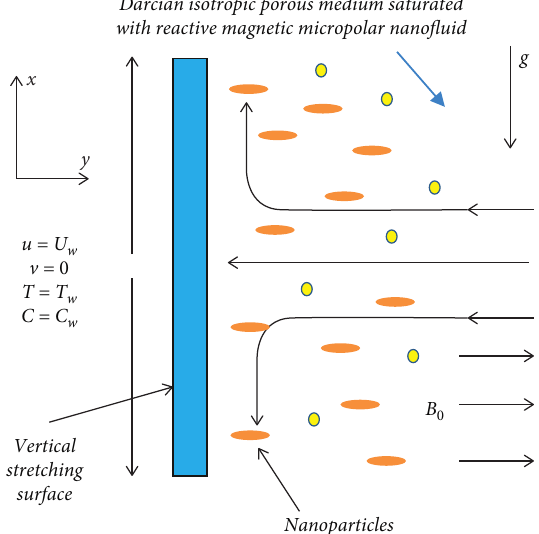
Figure 1: Geometrical